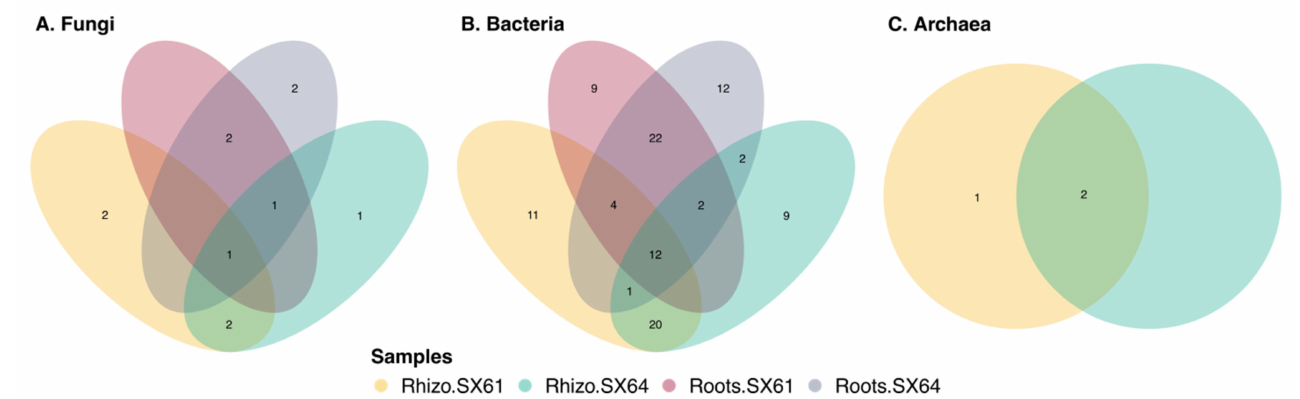
Figure 4. Venn diagram of shared ( A ) fungal, ( B ) bacterial, and ( C ) archaeal ASVs between all group